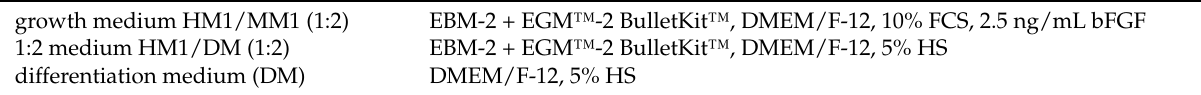
Table 2. Media composition for co-culture